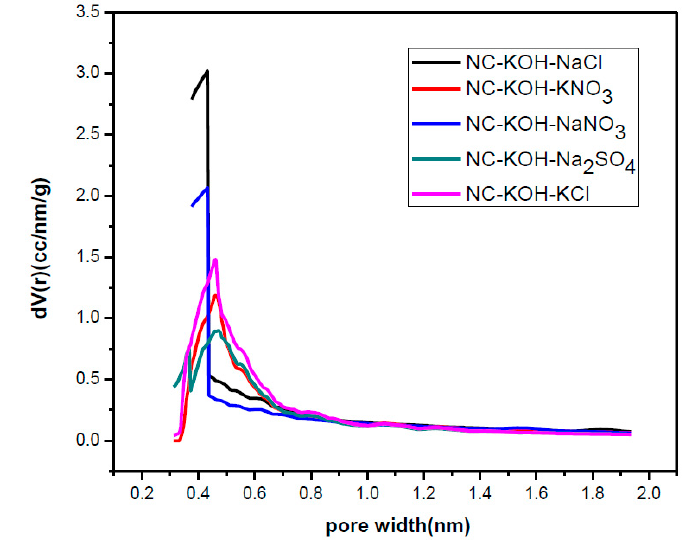
Figure 8. The micropore size distribution of samples activated by different salts.